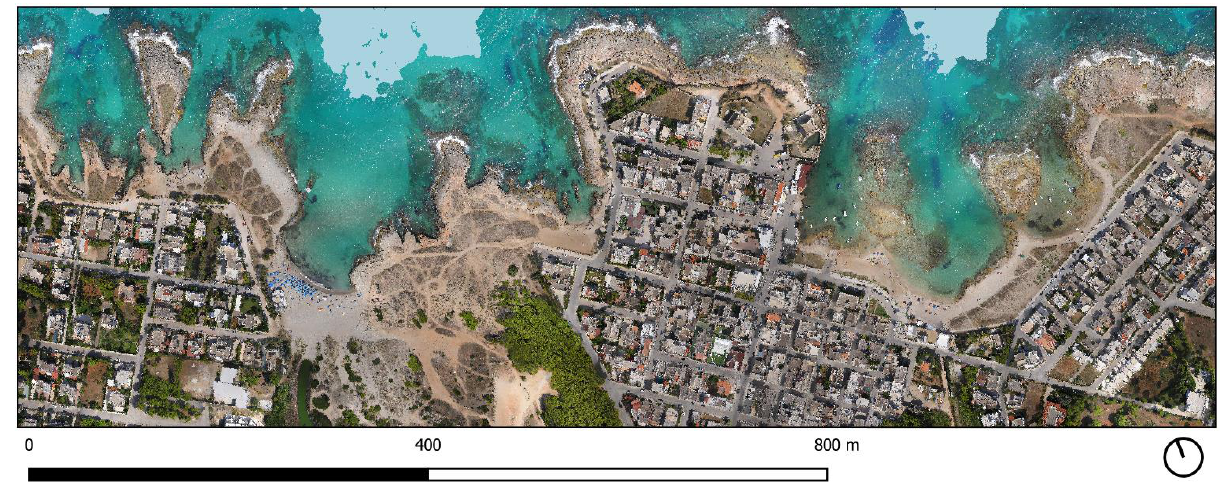
Figure 6 . UAS orthoimage of the shore of Santa Sabina (eBee X).